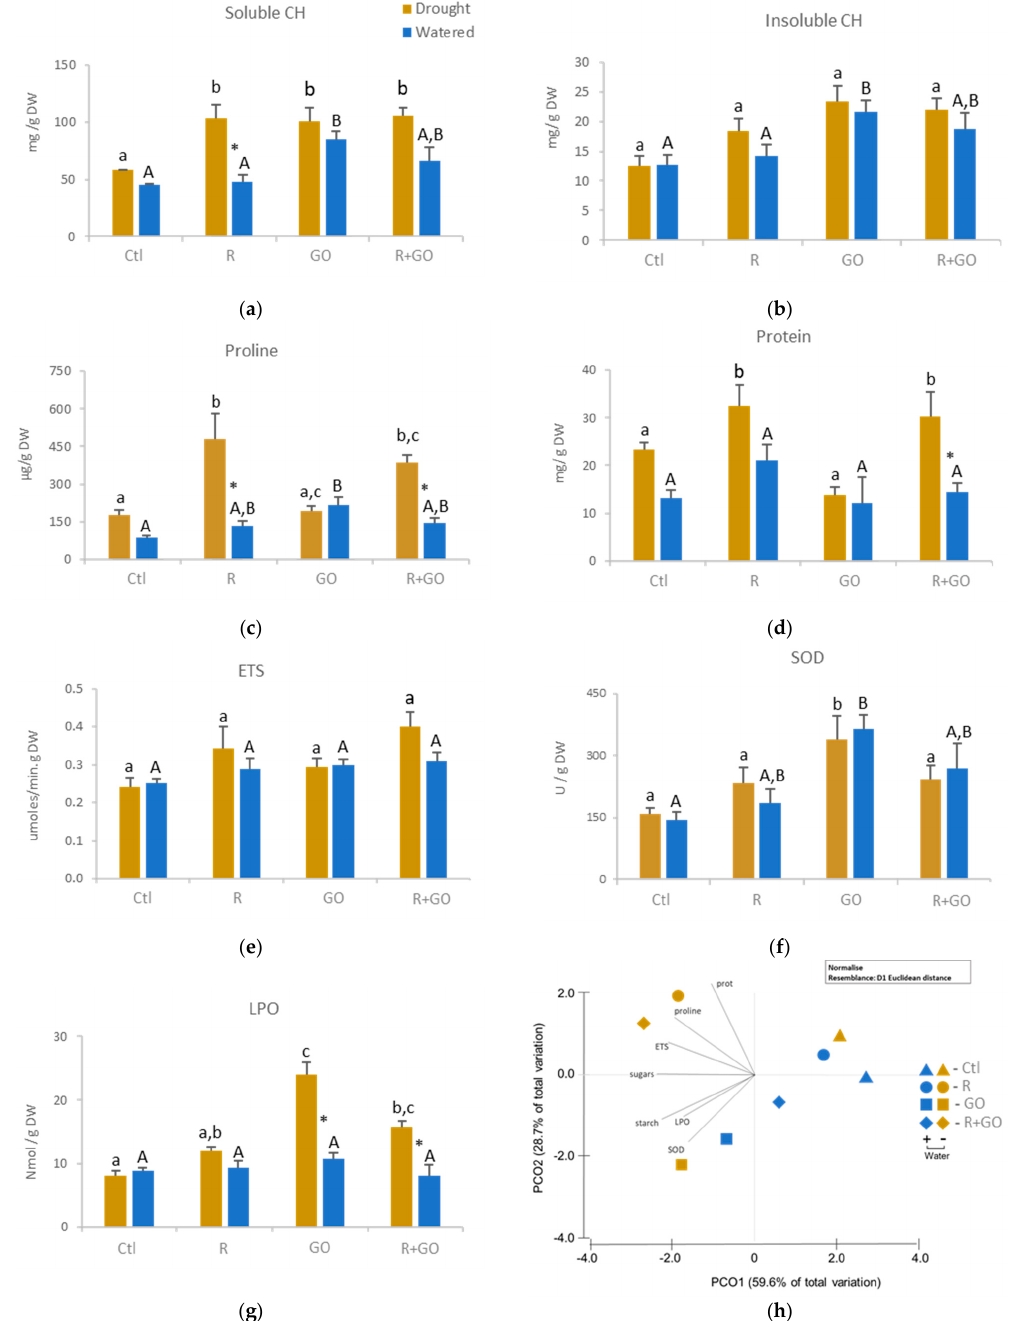
Figure 3. Biochemical parameters of the roots of watered (blue bars) or drought (brown bars) maize plants grown at different conditions (Ctl—no addition of graphene oxide nanosheets, no bacterial inoculation; R—no addition of graphene oxide nanosheets, inoculation with Rhizobium strain E20-8; GO—addition of graphene oxide nanosheets, no bacterial inoculation; R + GO—addition of graphene oxide nanosheets and inoculation with Rhizobium strain E20-8). ( a ) Soluble carbohydrates (CH); ( b ) insoluble carbohydrates; ( c ) proline; ( d ) protein; ( e ) electron transport system activity (ETS); ( f ) superoxide dismutase activity (SOD); ( g ) lipid peroxidation (LPO); ( h ) principal coordinates ordination of biochemical parameters in watered and drought plants at different conditions (Ctl, R, GO and R + GO). Values are means of three replicates + standard error. Different uppercase letters indicate significant differences ( p < 0.05) among conditions in watered plants, different lowercase letters indicate significant differences among conditions in drought plants, and asterisks indicate significant differences between drought and watered plants for the same